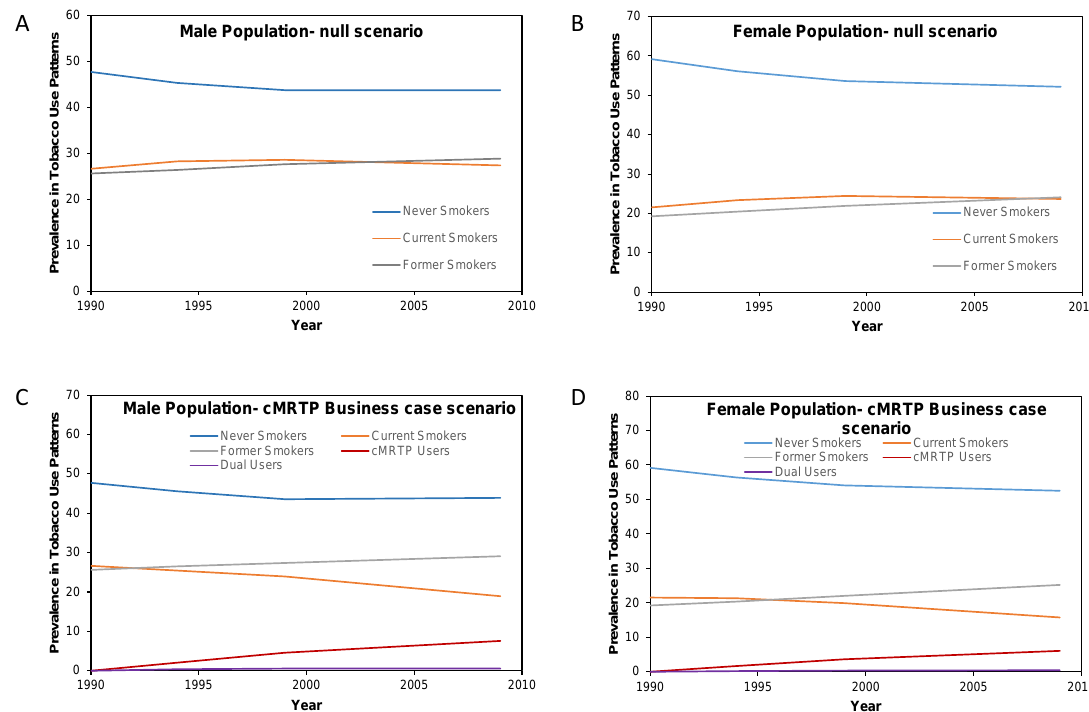
Figure 4. Change in smoking prevalence patterns by sex over the period 1990 to 2009 in the null scenario and in the cMRTP uptake case scenario by sex. ( A ) is the change in smoking prevalence over time in the male population under the null scenario while ( C ) is the change in smoking prevalence for the same male population under the Business case scenario. ( B ) is the change in smoking prevalence over time in the female population under the null scenario while ( D ) is the change in smoking prevalence for the same female population under the Business case scenario.